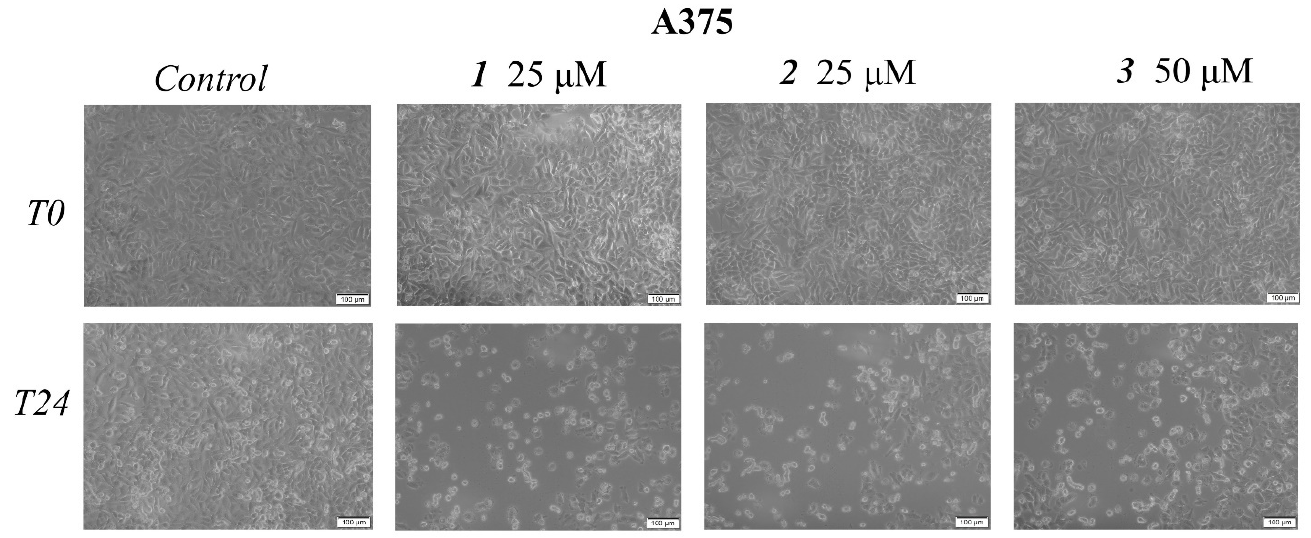
Figure 4. Representative images of the morphological aspects of A375 cells after treatment for 24 h with 1 , 2 (25 µ M), and 3 (50 µ M). The scale bar was 100 µ m.